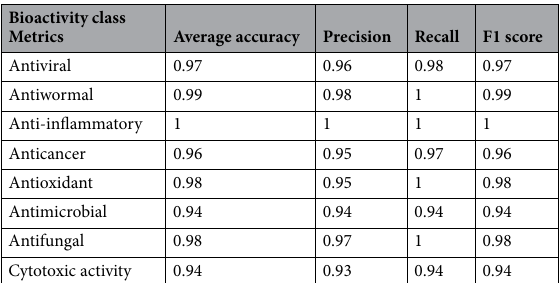
Table 4. The accuracy and relevance metrics for the predicting